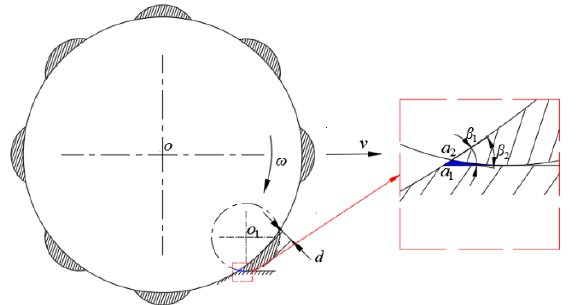
Figure 2. Mutual position diagram of circular arc-type edge line and soil. Note: a 1 is the contact point between the base circle and the soil; a 1 is the vertex corresponding to diagonal β 1 ; a 2 is the contact point between the contour curve and the base circle; a 2 is the vertex corresponding to β 2 .